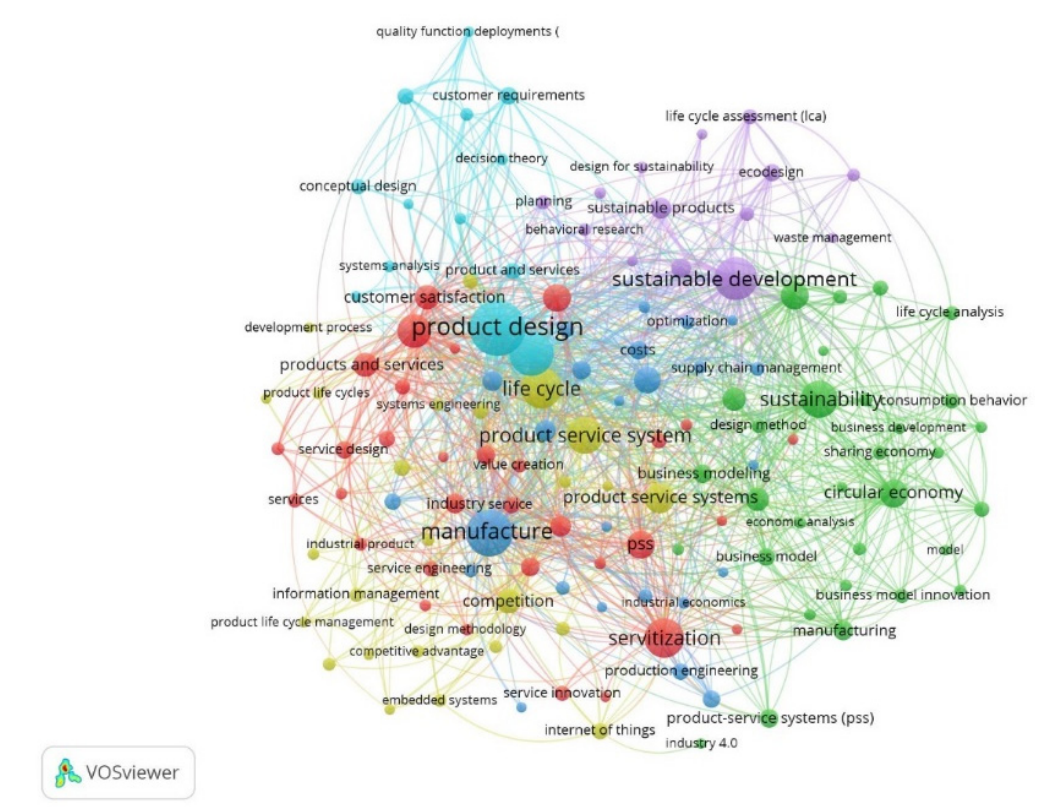
Figure 7. Main keywords network based on co-occurrence from 2000 to 2020.